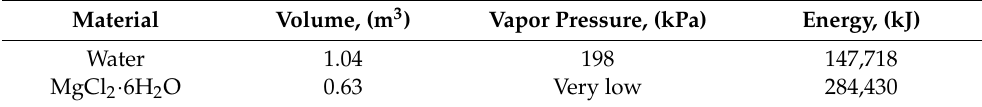
Table 3. Comparison of materials as storage